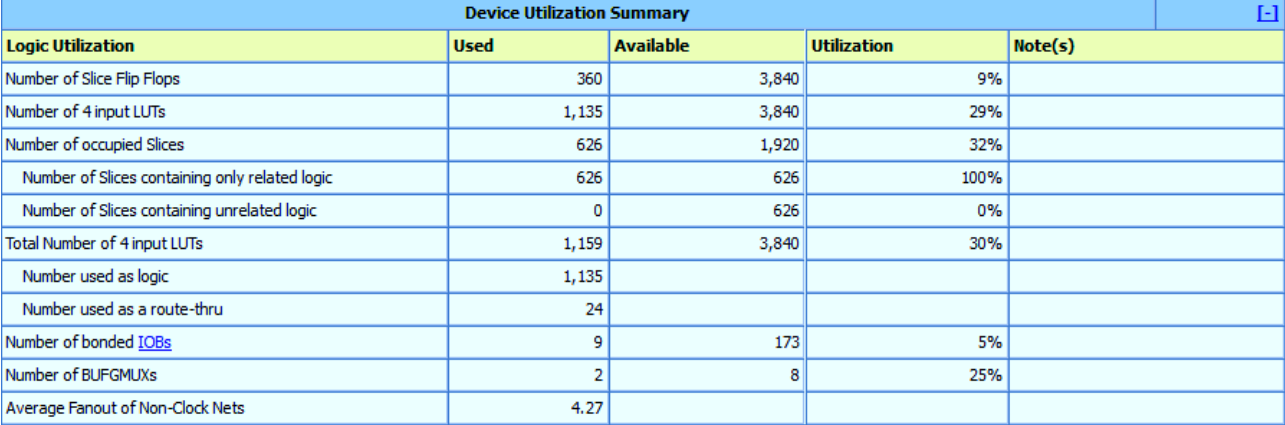
Figure 9. Estimated Power for 2x2 mesh NoC on